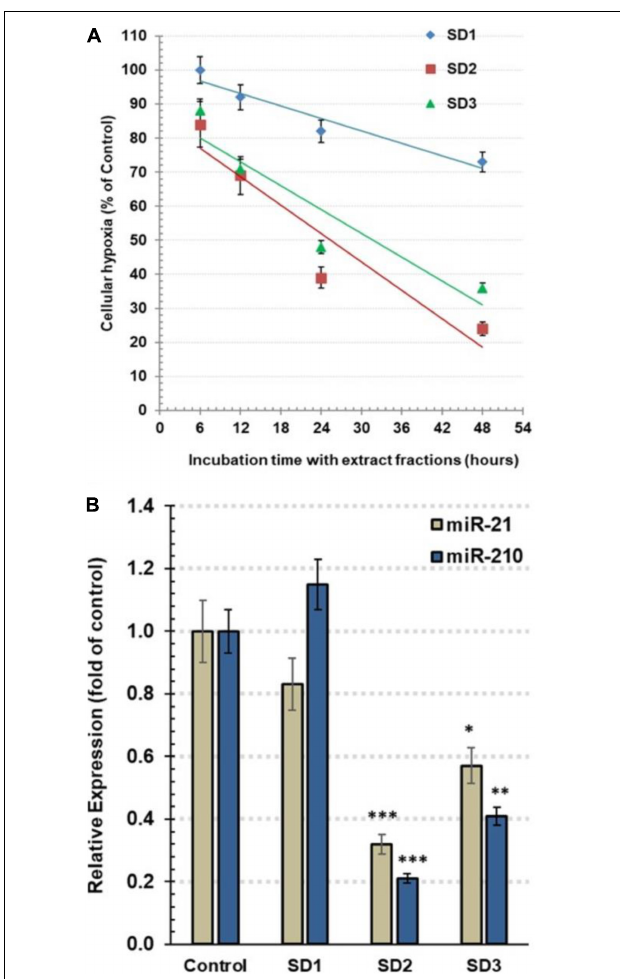
FIGURE 3 | (A) Estimation of the total hypoxia degree by pimonidazole in CAL-27 cells. The cells were co-cultured with 30% of IC 50 of each fraction for 6, 12, 24, and 48 h. The results are expressed as percentage of control (mean ± SD; n = 6), where control was 1,374 IFU. (B) The relative expression of hsa-miRNA-21-5p and hsa-miRNA-210-3p in CAL-27 cells after being treated with 30% of IC 50 of fractions for 48 h. Data are expressed as mean ± SD, n = 8. ∗ p < 0.05, ∗∗ p < 0.01, and ∗∗∗ p < 0.001 compared to the corresponding